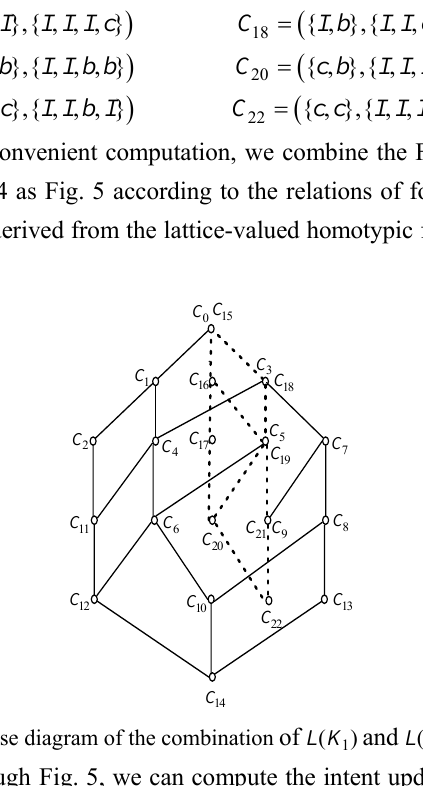
Fig. 5 Hasse diagram of the combination of